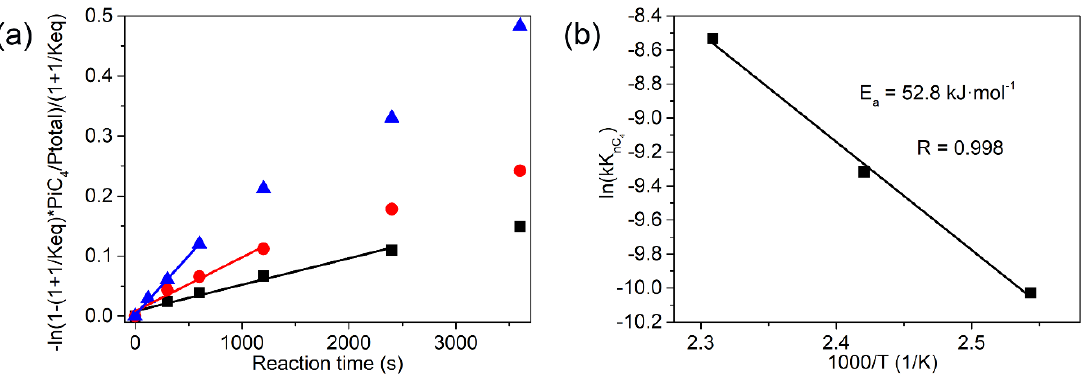
Figure 8. The kinetic study of butane isomerization at different temperatures catalyzed by M-SZ-2. ( a ) − ln[1 − (1 + 1/K eq )P iC 4 /P total ]/(1 + 1/K eq ) vs. reaction time at ( ■ ) 393 K, ( ● ) 413 K, and ( ▲ ) 433 K, and ( b ) ln(kK nC 4 ) vs. 1000/T. Table 4. The kinetic constants of butane isomerization catalyzed by M-SZ-2 at 393 ~ 433 K. Reaction Temperature (K)